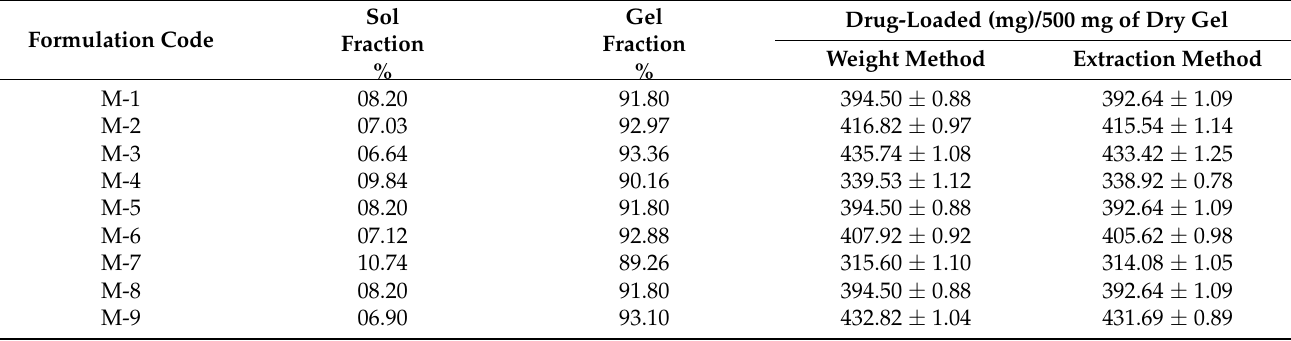
Table 2. Sol-gel analysis and drug loading of CS/Al-g-pAa hydrogels.